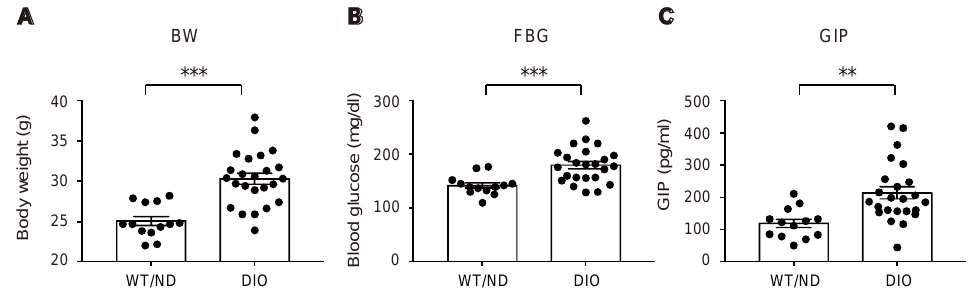
Figure 1. Effect of high-fat diet (HFD) on body weight, blood glucose levels, and plasma glucose-dependent insulinotropic polypeptide (GIP) levels. Body weight ( A ), blood glucose levels ( B ), and plasma GIP levels ( C ) were measured in wild-type (WT) mice fed normal chow diet (ND) (WT/ND) or HFD (diet-induced obese, DIO) for four weeks, then fasted overnight before sampling. Each data point is plotted as a circle. Bars depict mean ± SEM. ** p < 0.01, *** p < 0.001.